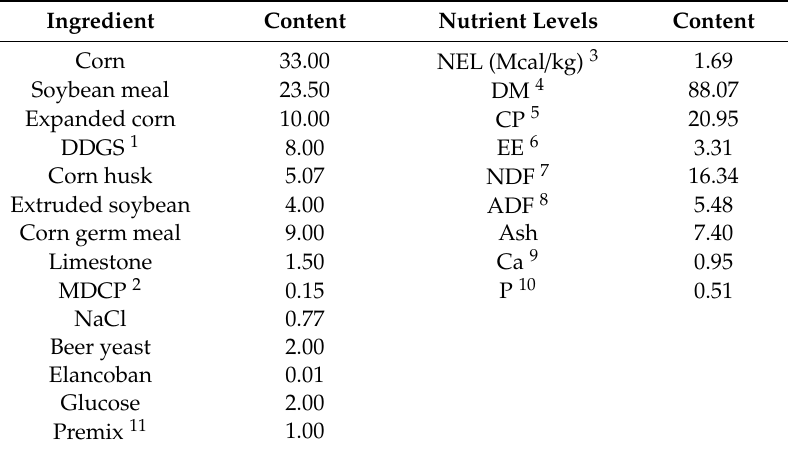
Table 3. Composition and nutrient levels of the starter (DM basis,